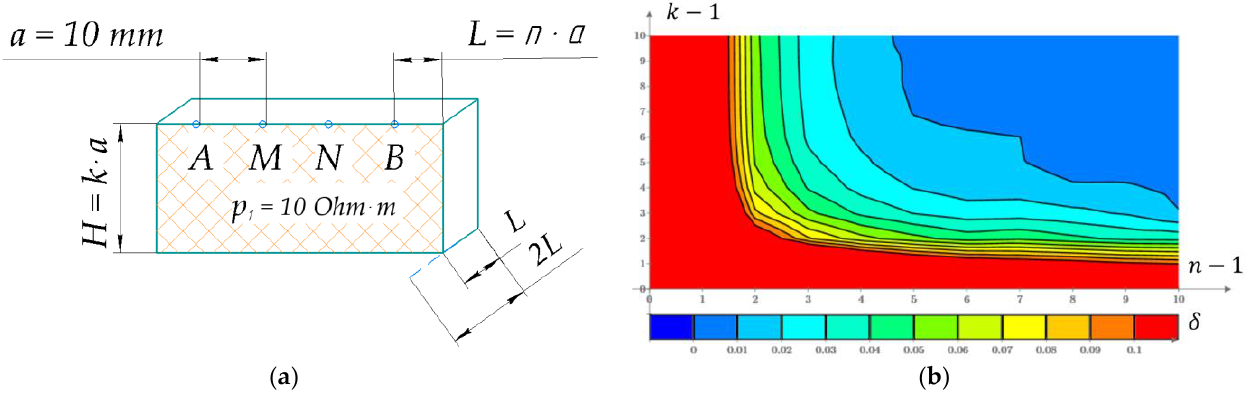
Figure A1. EI model ( a ) and the results of comparison EI simulated with the analytical one ( b ) to determine the geometric dimensions.